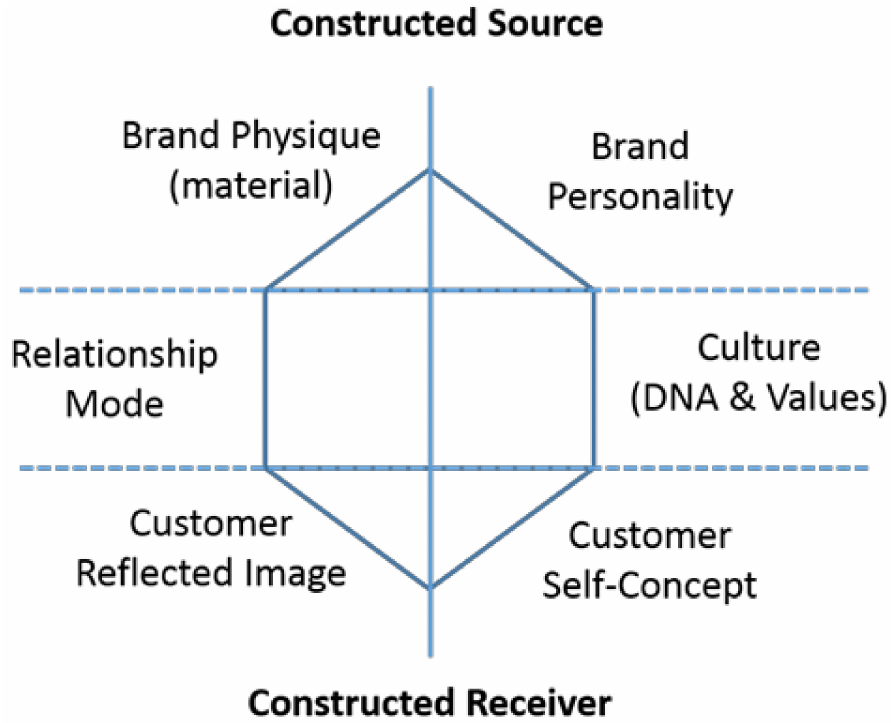
Figure 2. Identify Prism Model for a fine wine